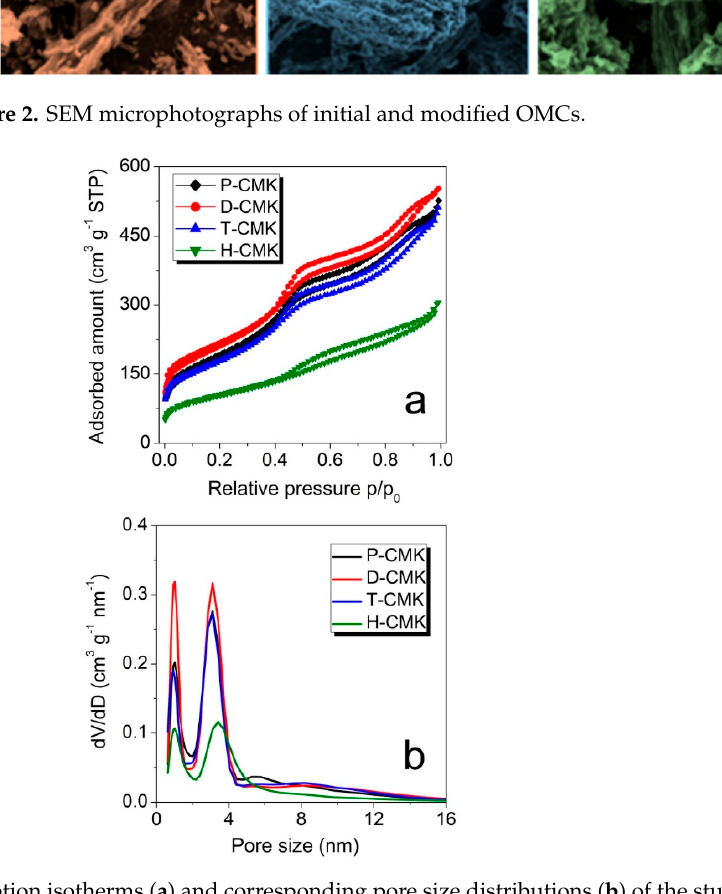
Figure 3. Nitrogen sorption isotherms ( a ) and corresponding pore size distributions ( b ) of the studied carbons. Table 1. Results derived from the nitrogen sorption, ζ potential, Raman, XPS measurements, and pH measurements.